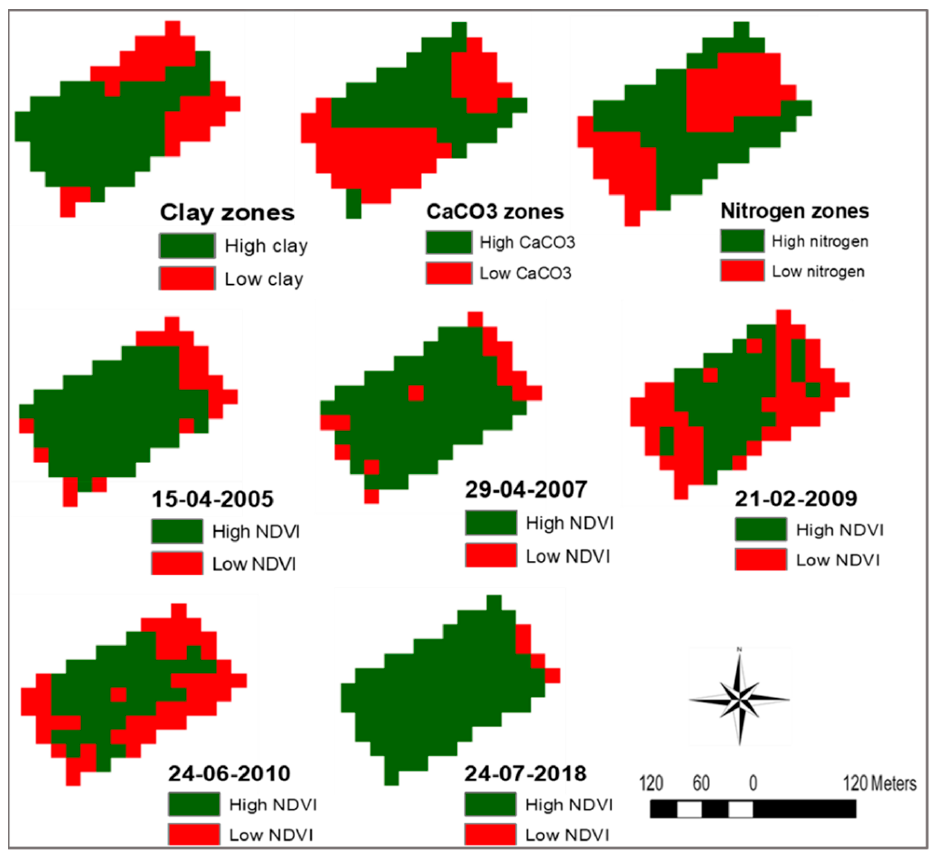
Figure 6. Two-zone maps of single soil properties and NDVI indices (these latter simply indicated by their acquisition dates). Table 12. Statistical differences between two-zone single soil properties and NDVI indices, and their pixel agreements (percentage) with two-zone multiple crops yield map.